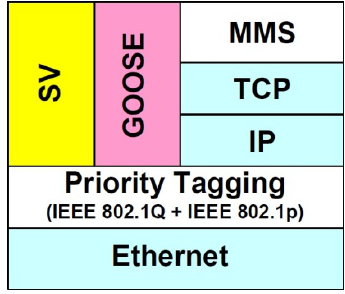
Figure 2. GOOSE communication stacks [20] (Copyright